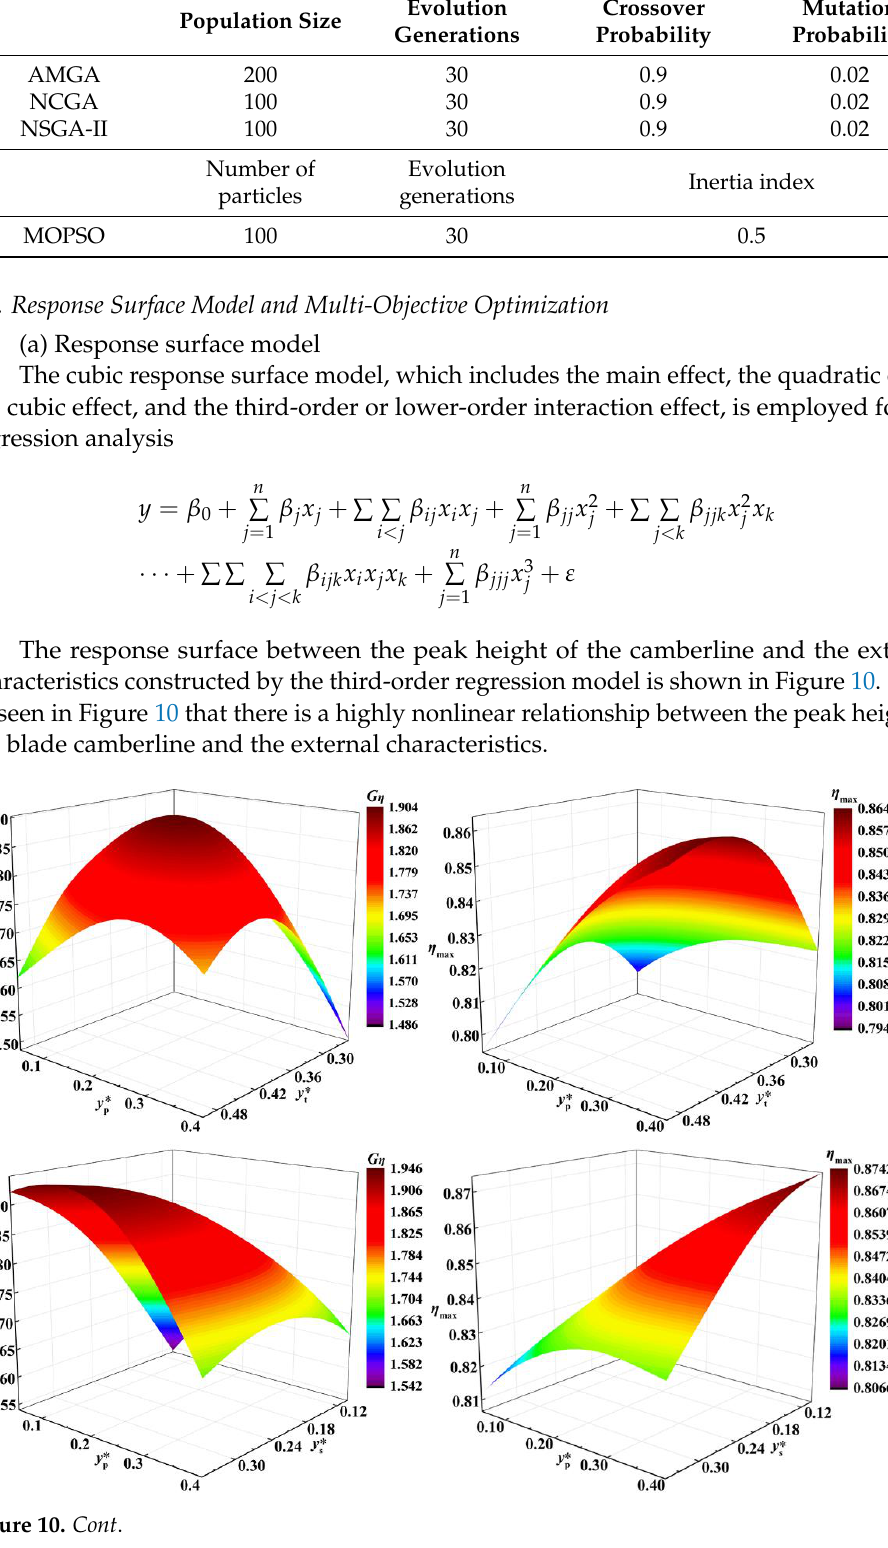
Figure 10. Nonlinear relationship between parameters and performances. Ten sample monitoring points are selected to evaluate the fitting accuracy of the re- sponse surface model (Figure 11). According to the predicted value of the response surface and the actual calculated values of the 10 sample monitoring points, the R 2 value can be calculated by Equation (22). The closer R 2 is to 1, the higher the fitting accuracy of the response surface model. It is concluded that the R 2 values of G η and η max are 0.99136 and 0.96857, respectively, which are both greater than 0.9, indicating that the response surface model is very reasonable.